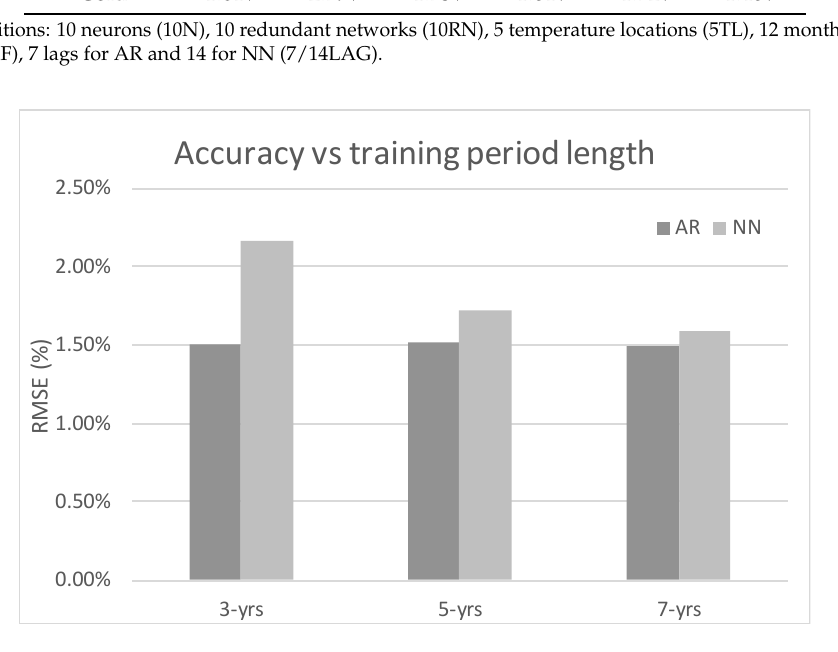
Figure 8. Overall forecasting error (RMSE) with training periods from 3 to 7 years.